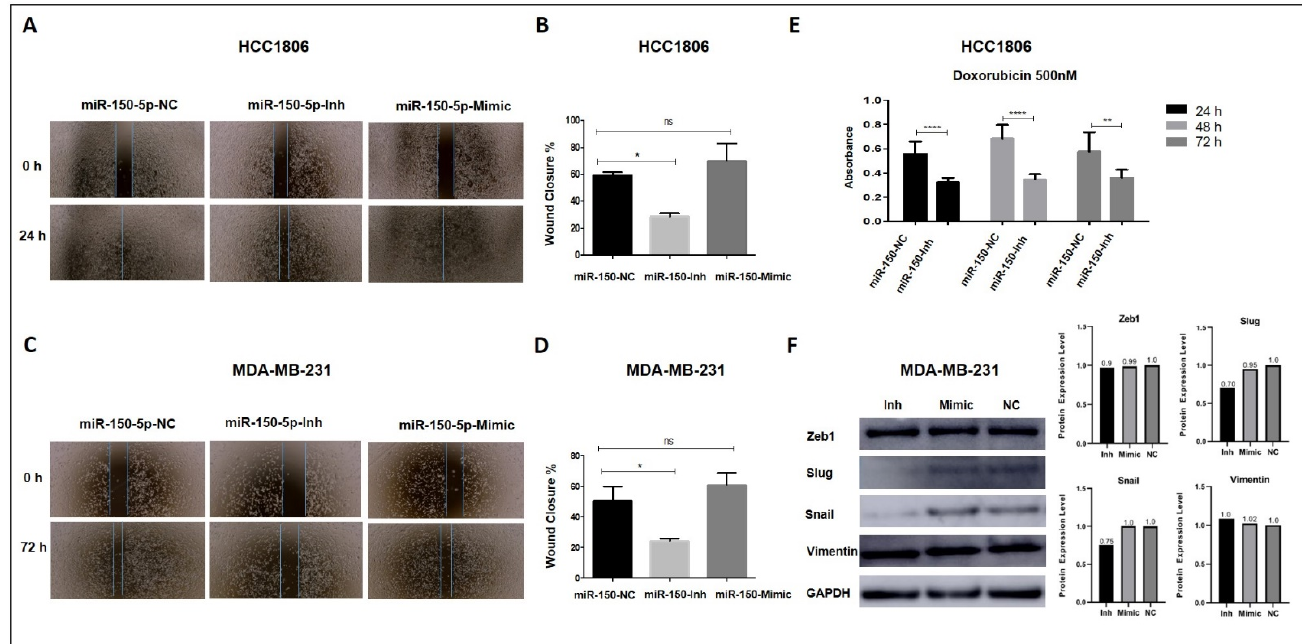
Figure 4. Cell migration and cytotoxicity assays in the TNBC transfected cells. ( A – D ) Inhibition of miR-150-5p reduced migration in HCC1806 ( A , B ) and MDA-MB-231 ( C , D ) cells. In contrast, ectopic expression of miR-150-5p had no effects on cell migration. ( E ) Inhibition of miR-150-5p reduced cytotoxicity of doxorubicin in HCC1806. ( F ) Western blotting analysis and quantitative readings of epithelial-to-mesenchymal transition markers in MDA-MB-231 cells. * p < 0.05; ** p < 0.01; **** p < 0.0001; ns = not significant. NC: negative control.